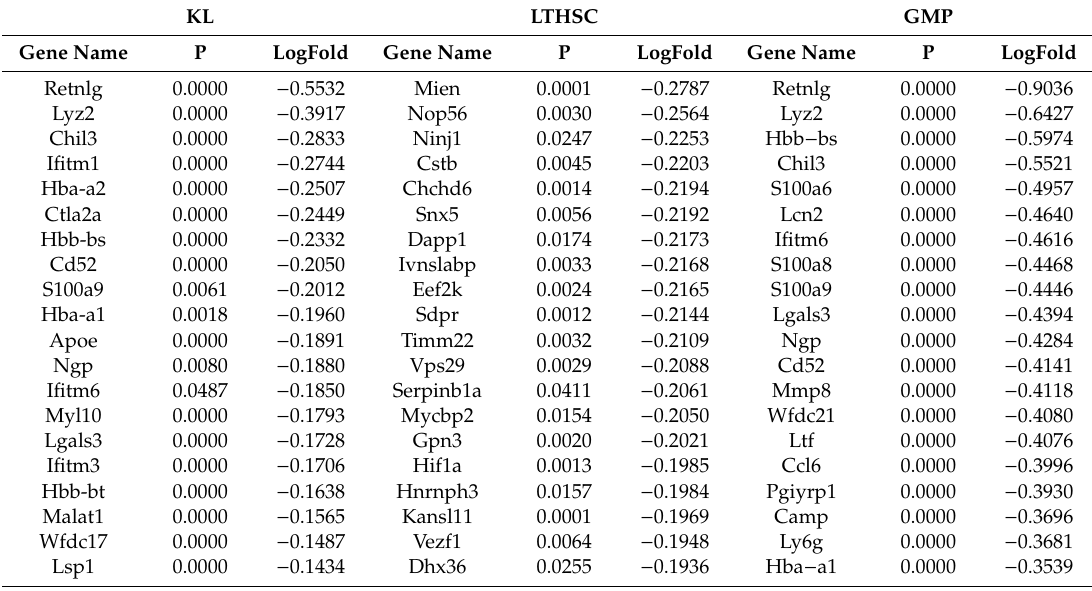
Table A3. Genes down-regulated in KL, LTHSC, and GMP hematopoietic cells from CVT mice at one month after co-housing relative to SPF mice. KL LTHSC